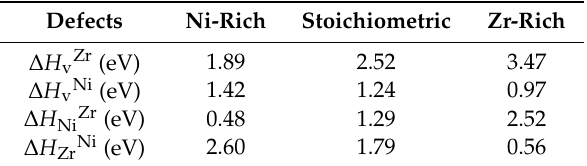
Table 5. Theoretical effective formation energies for point defects in Zr 2 Ni 7 at 1000 ˝ C.